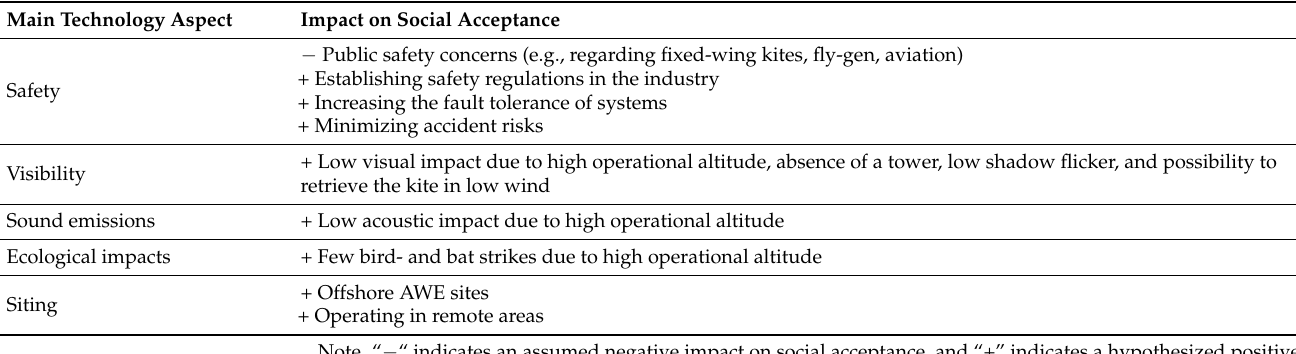
Table 2. Overview of the technical aspects that the reviewed literature speculates will shape the social acceptance of airborne wind energy